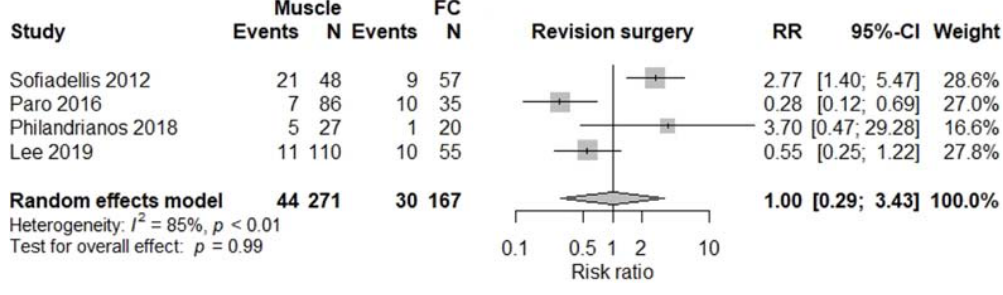
Figure 7. Need for revision surgery. Although not statistically significant, these pooled results showed a trend of higher complications observed in the M flap group. Finally, the exclusion of most studies from the analysis using the leave-one-out sensitivity analysis did not materially change the summary estimates (Table 2). Table 2. Leave-one-out sensitivity analysis. Pooled RR Pooled